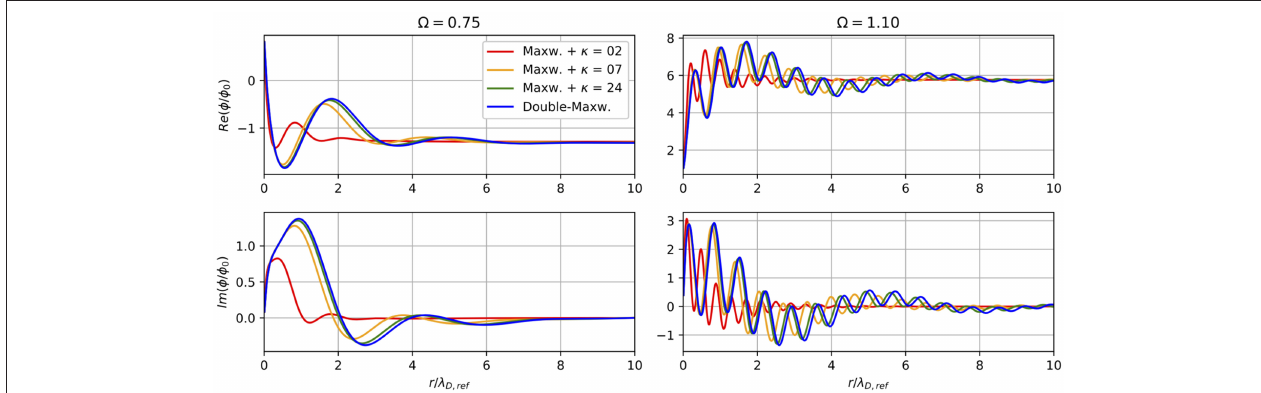
0.75 (left column) and (cid:127) 1.10 (right column) = = 0.4 and τ 100), for (i) a mix of a core Maxwellian and a = =